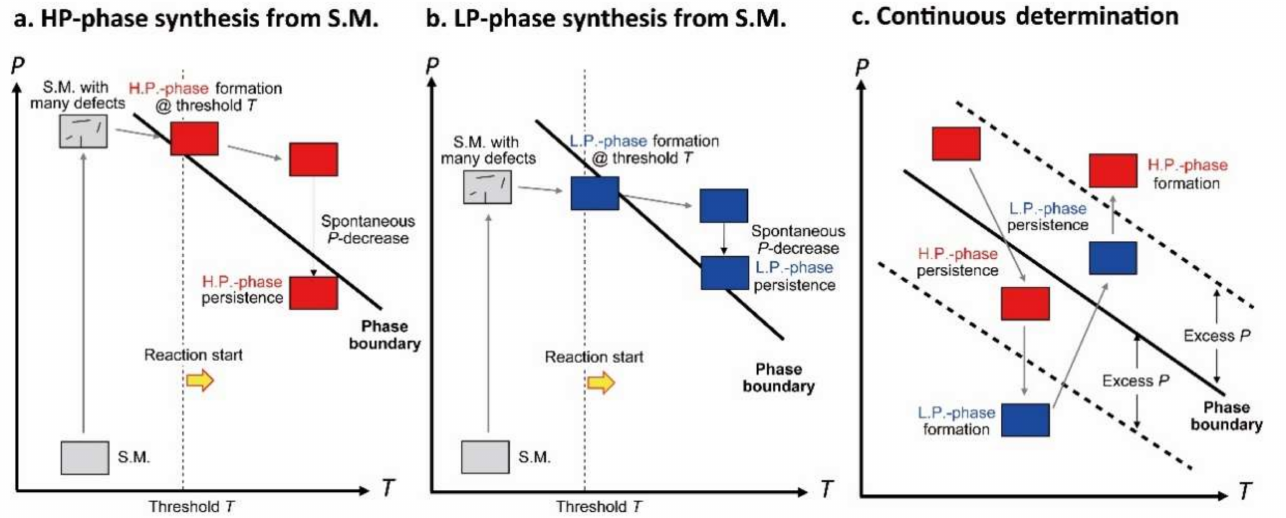
Figure 3. A schematic drawing of problems on in situ determination in a multi-anvil press. ( a ) After cold compression, when a starting material (S.M.) was brought above the phase boundary, it could become the H.P.-phase during heating if the target temperature were higher than the threshold temperature of the transition. After reaching the target temperature, the H.P.-phase might have already appeared and persist due to its sluggish kinetics even though the sample was below the phase boundary by pressure drop. ( b ) When the sample passed below the phase boundary during heating, the starting sample should first become the L.P.-phase at the threshold temperature. If the sample crossed the phase boundary until it reached a target temperature, the L.P.-phase might persist even above the boundary due to the sluggish kinetics. ( c ) When the in situ synthesized sample crossed the phase boundary, excess pressure should be needed to initiate the transition due to fewer defects in the structure. Thus, the phase boundary could be either underestimated or